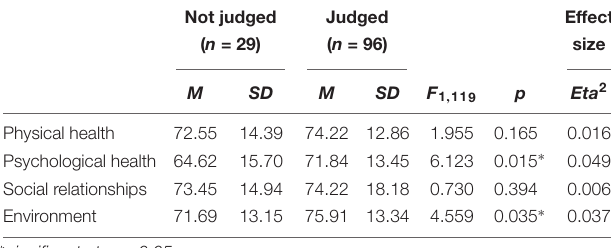
TABLE 4 | Comparisons of the four WHOQOL-BREF dimensions between musicians who take part in judged performances and those who do not. Not judged Judged